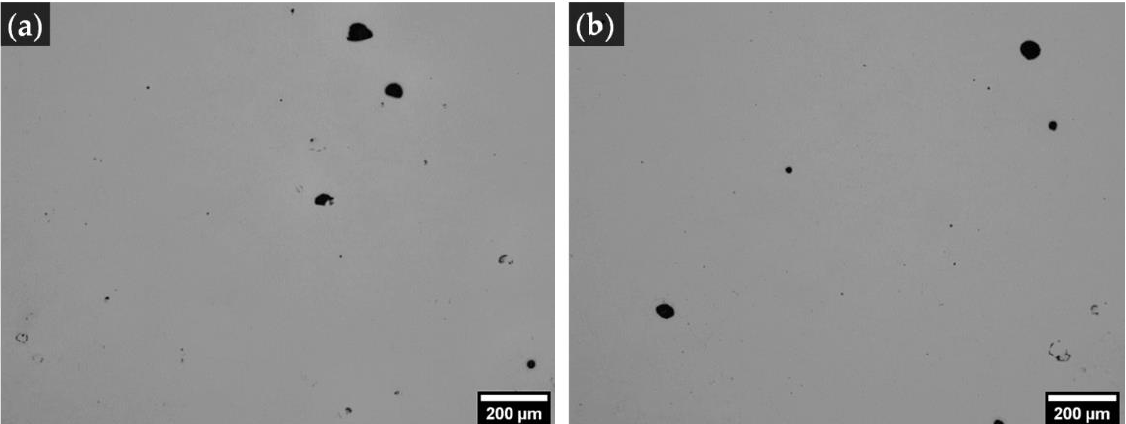
Figure 8. Representative images ( a , b ) of porosity within SLM RS-333 aluminium alloy parts taken in the X-Z sectional plane orientation.